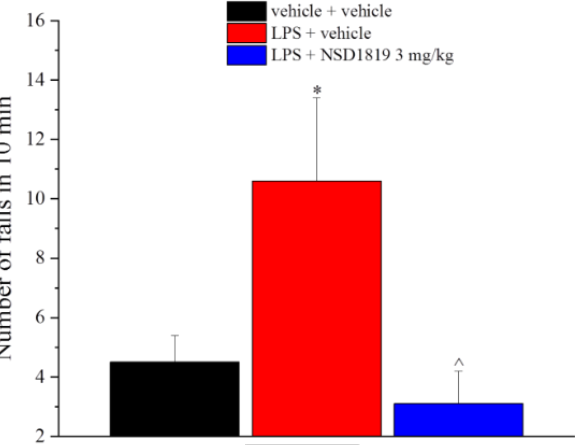
Figure 3. Effect of NSD1819 on LPS-induced motor alterations. LPS (1 mg/kg) was intraperitoneally injected for five consecutive days (from 1 to 5). NSD1819 was suspended in 1% carboxymethylcellulose sodium salt (CMC) and daily orally administered starting from day 1 until the end of the experiment. Control animals were treated with vehicles. On day 8, 16 h after the last administration of the compound, the motor coordination was assessed by the Rota rod test. Data are expressed as the mean ± S.E.M. of values from 8 mice analyzed in 2 different experimental sets. * p < 0.05 vs. vehicle + vehicle; ˆ p < 0.05 vs. LPS + vehicle.